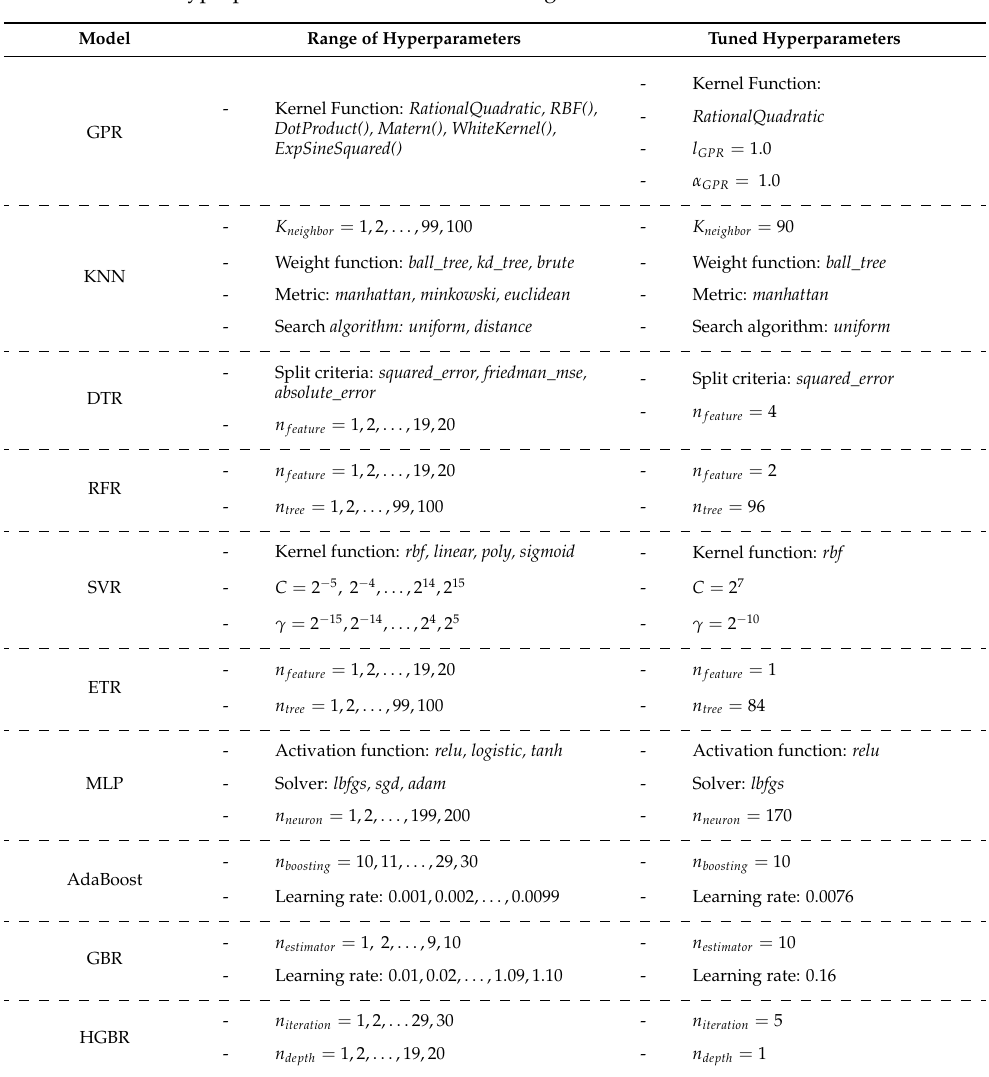
Table A2. Tuned hyperparameters for machine learning